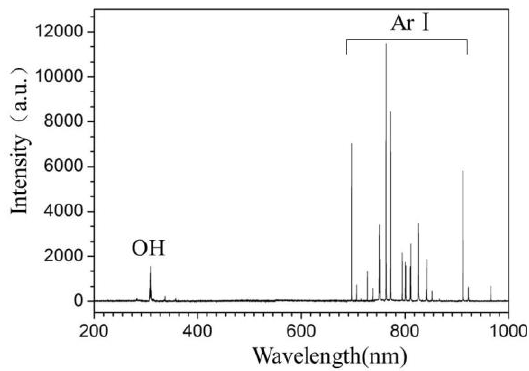
Figure 5. Optical emission spectrum of APLTP.